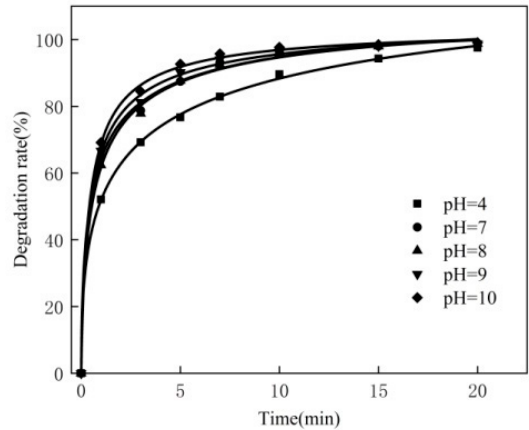
Figure 4. Effect of pH.